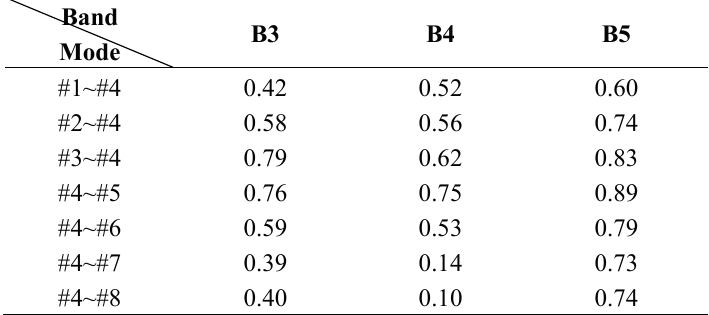
Table 3. The correlation coefficient (CC) of MODIS images between the base and predicted dates in the CIA site. For example, “#1~#4” denotes the CC value between the prior MODIS image on 8 October 2001 (#1) and the MODIS image on 9 November 2001 (#4).